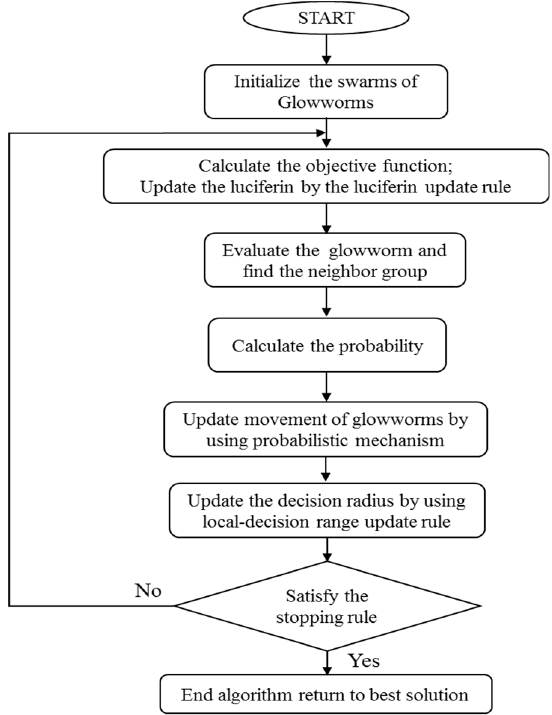
Figure 1. Flowchart of the Glow-worm Swarm Optimization (GSO) algorithm. Energies 2020 , 13 , x FOR PEER REVIEW